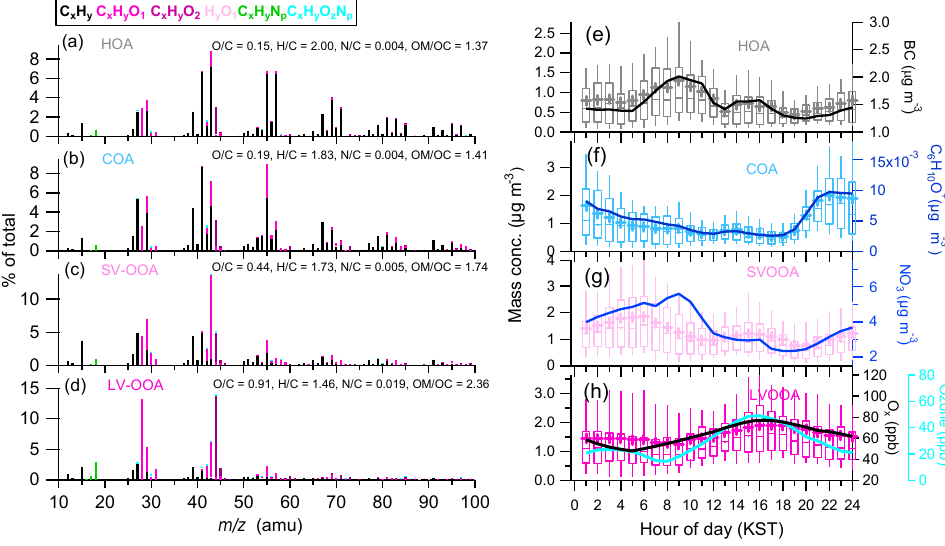
Figure 8. Overview of the results from PMF analysis including high-resolution mass spectra of the (a) hydrocarbon-like organic aerosol (HOA), (b) cooking OA (COA), (c) semi-volatile oxygenated OA (SV-OOA), and (d) low-volatility oxygenated OA (LV-OOA) colored by different ion families; (e–h) average diurnal profiles of each of the OA factors (the 90th and 10th percentiles are denoted by the whiskers above and below the boxes, the 75th and 25th percentiles are denoted by the top and bottom of the boxes, the median values are denoted by the horizontal line within the box, and the mean values are denoted by the colored markers) with various tracer species.